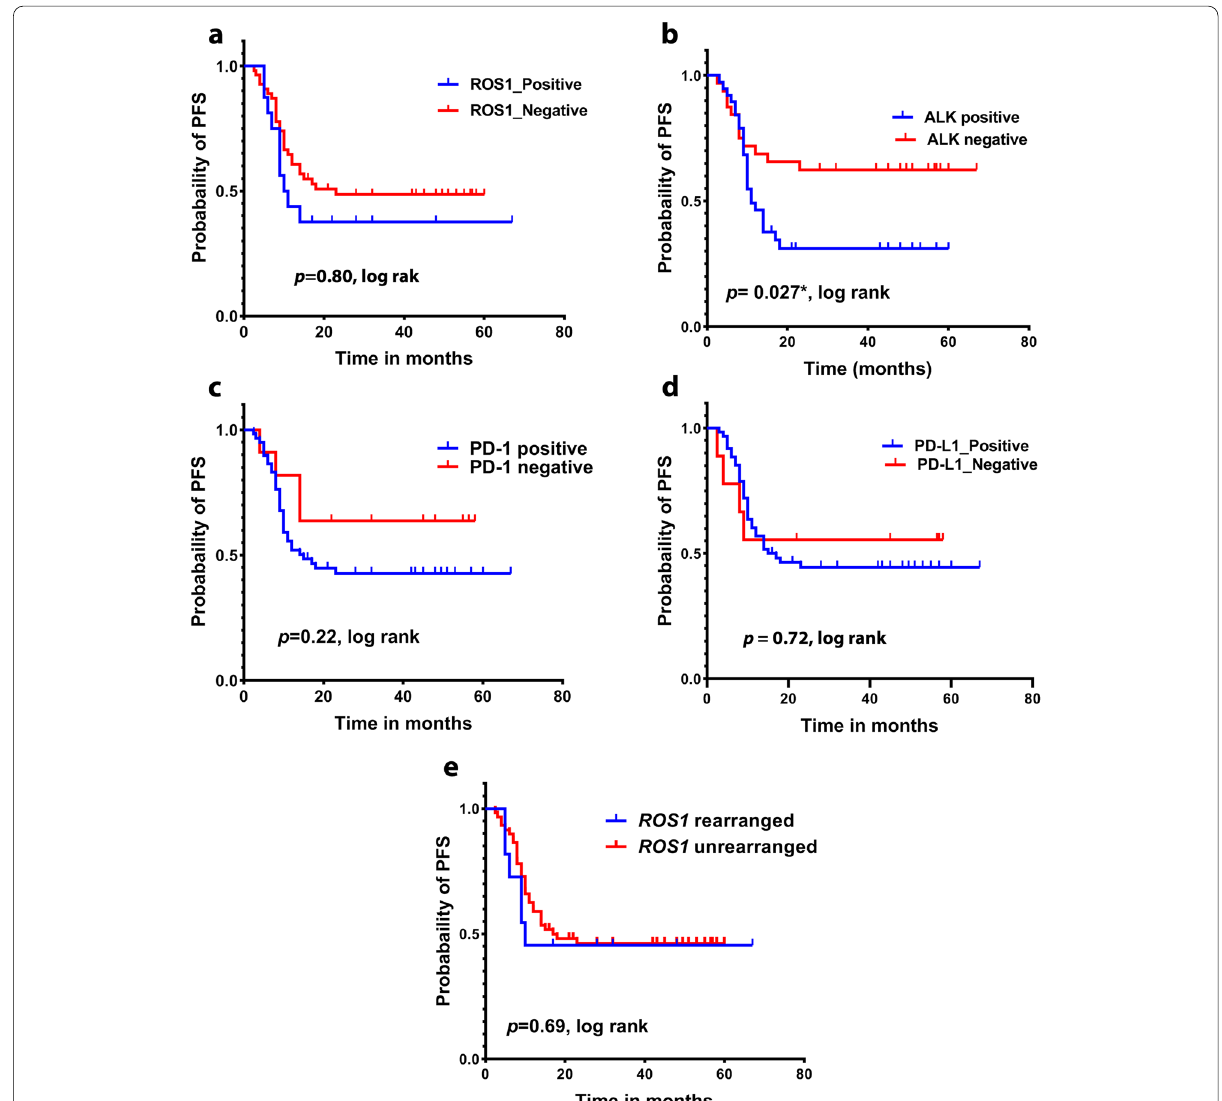
Fig. 3 Kaplan‑Meier survival analysis curve for the progression free survival (PFS) in relation to expression of a ROS1, b ALK, c PD‑1, and d PD‑L1 and in relation to e ROS1